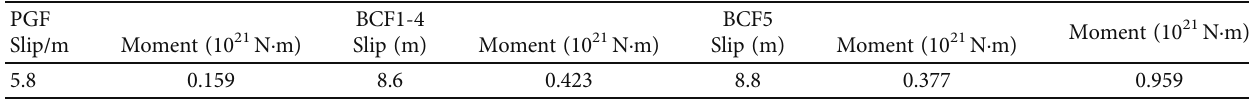
Table 2. The seismic moment is 0 : 959 × 10 21 N · M . Accord-